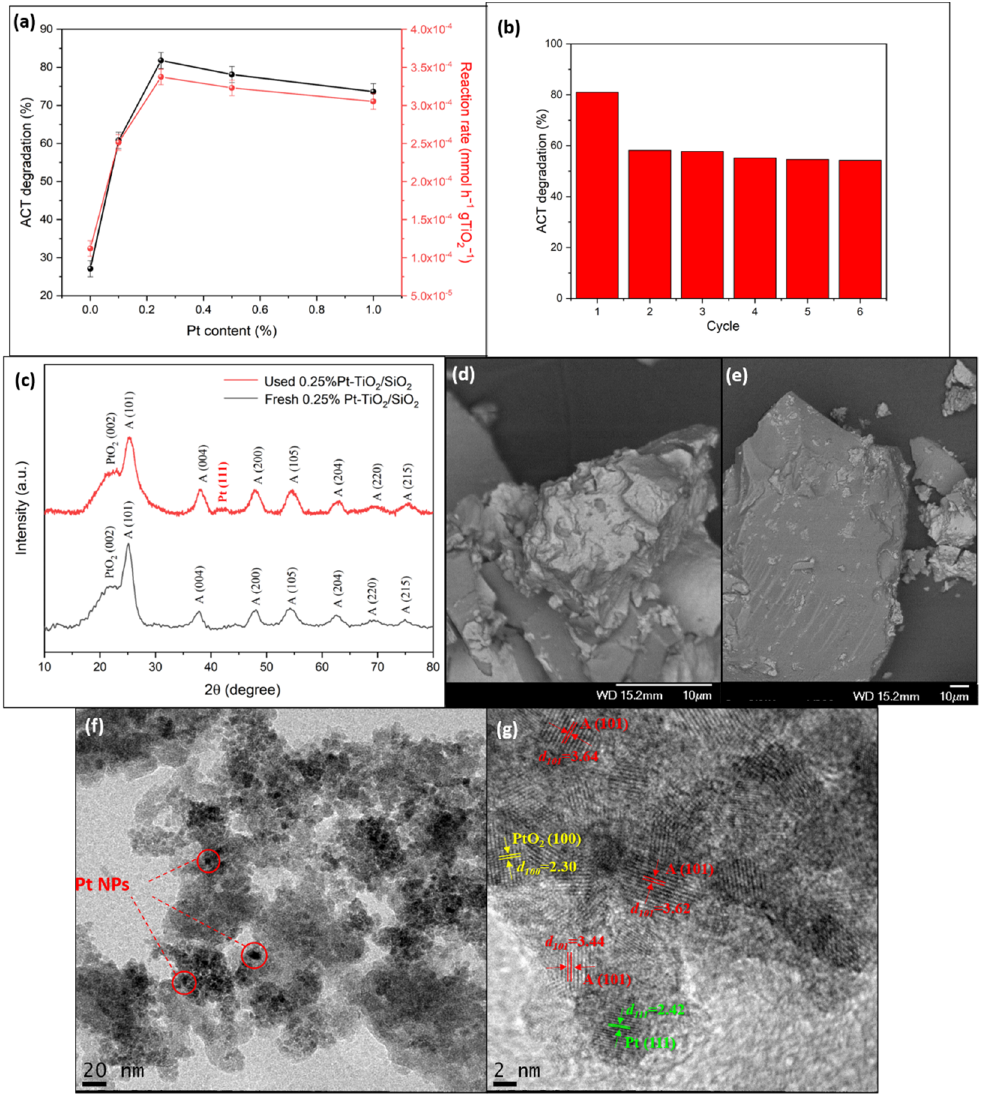
Figure 6. ( a ) Photocatalytic activity of TiO 2 /SiO 2 samples with different Pt contents (ACT inlet concentration, 0.033 mmol L − 1 ; volumetric flow rate, 3 mL h − 1 , space time, 1 h. Error bars are based on triplicates of the optimum point). ( b ) Evaluation of the stability of 0.25%Pt-TiO 2 /SiO 2 under continuous operation for six reuse cycles. ( c ) XRD diffractograms of fresh and reused materials. ( d , e ) SEM images of reused material. ( f , g ) TEM and HRTEM images of reused material.